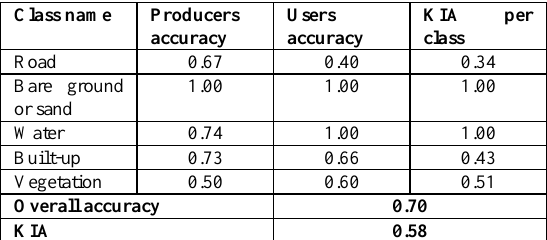
Table 1: Accuracy assessment and kappa statistics for pixel-based supervised method (Maximum Likelihood Classification)